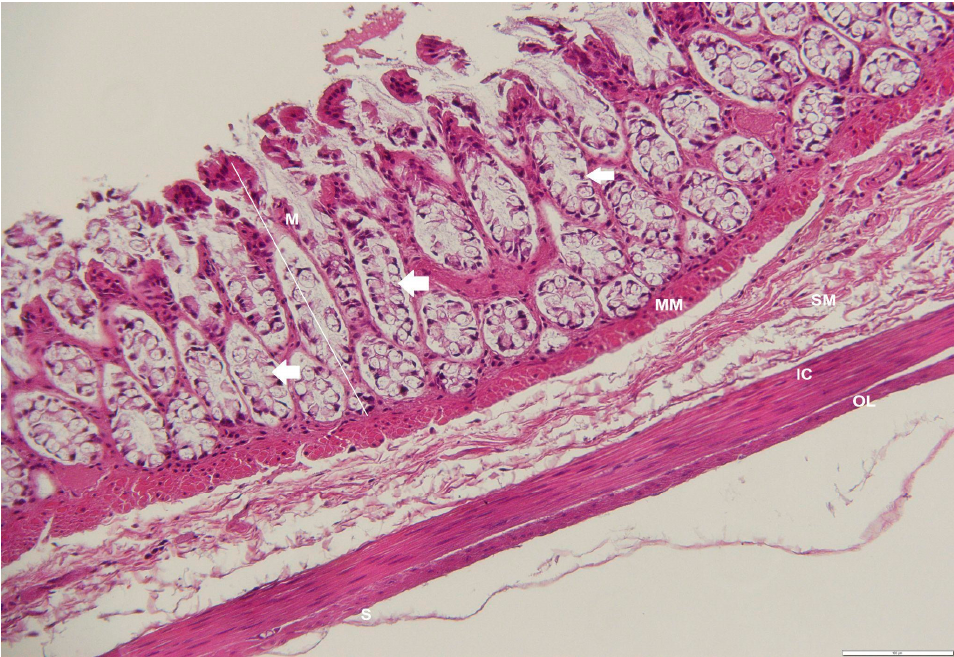
Figure 13. Photomicrograph of a cross-section through the colon of an adult male D. leporina , showing goblet cells (arrows). H&Ex200. M—mucosa; MM—muscularis mucosa; SM—submucosa; IC—inner circular layer; OL—outer longitudinal layer; S—serosa. The rectal mucosa was lined with a large number of goblet cells, and the tubular